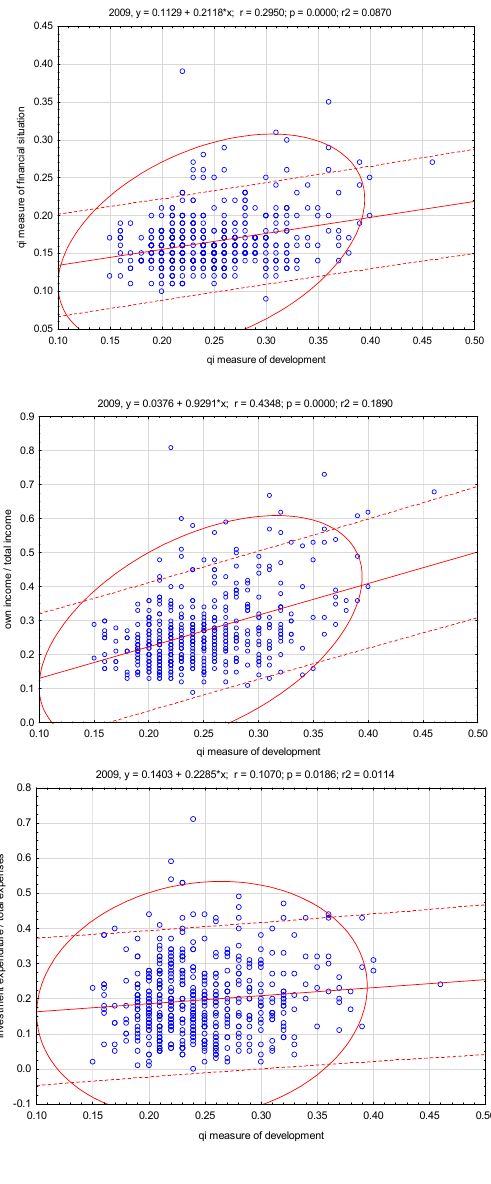
Figure 3. Dispersion of the synthetic measure of the financial situation of rural communes in eastern Poland in 2009 and 2018. Source: own research.